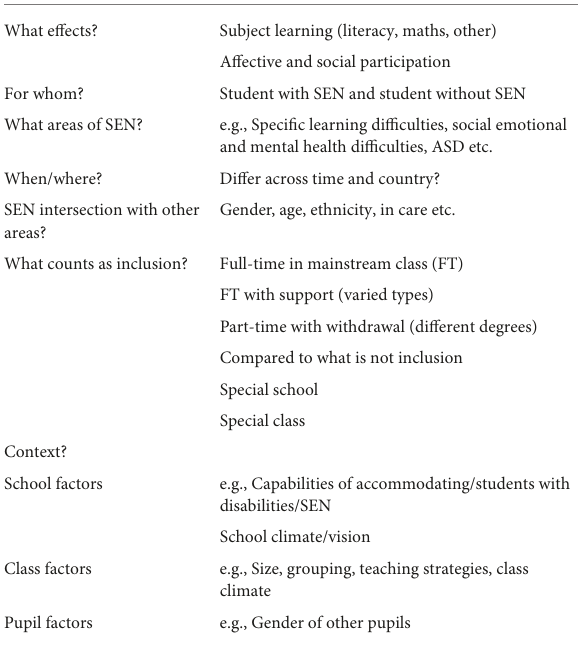
TABLE 1 Framework of focus and interacting factors relevant to the effects of inclusive